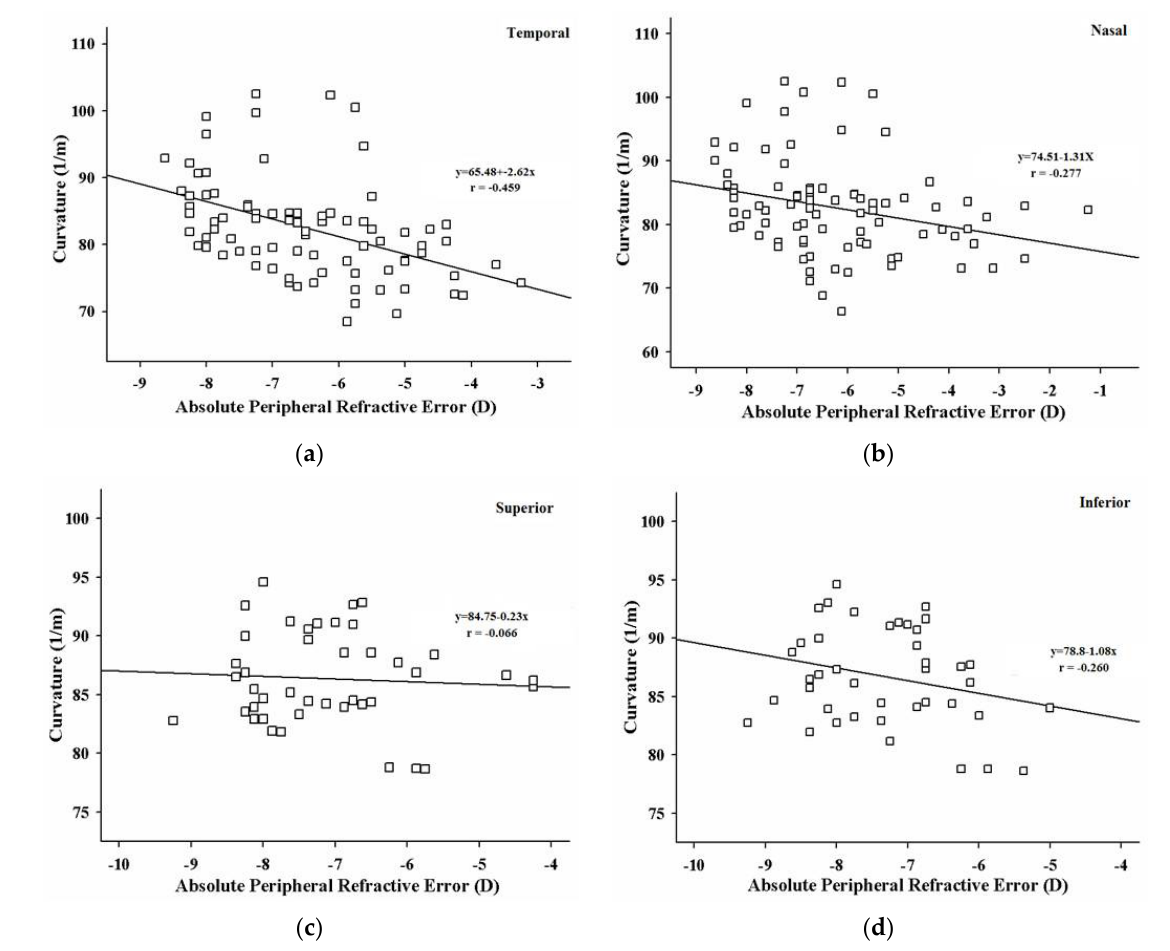
Figure 4. The graphs showed the negative correlations between the retina’s curvature and the peripheral refraction in the highly myopic group. ( a ) There was a significant correlation between the retina’s curvature and the peripheral refraction in the retina’s temporal area (r = − 0.459; p < 0.01). ( b ) There was a significant correlation between the retina’s curvature and the peripheral refraction in the nasal area (r = − 0.277; p = 0.011). ( c ) No significant correlation was found in the superior retina. ( d ) No significant correlation was found in the inferior